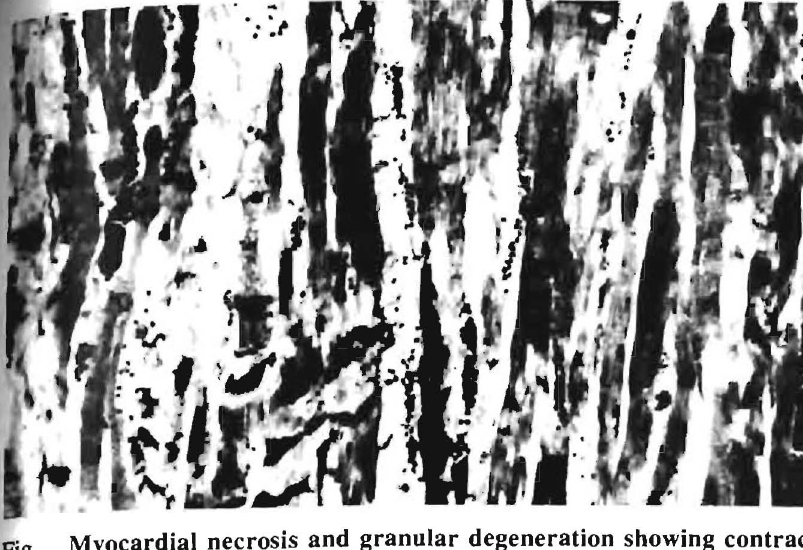
Fig. Myocardial necrosis and granular degeneration showing contraction bands and myolysis in goats with suspected avocado poisoning. HE X400